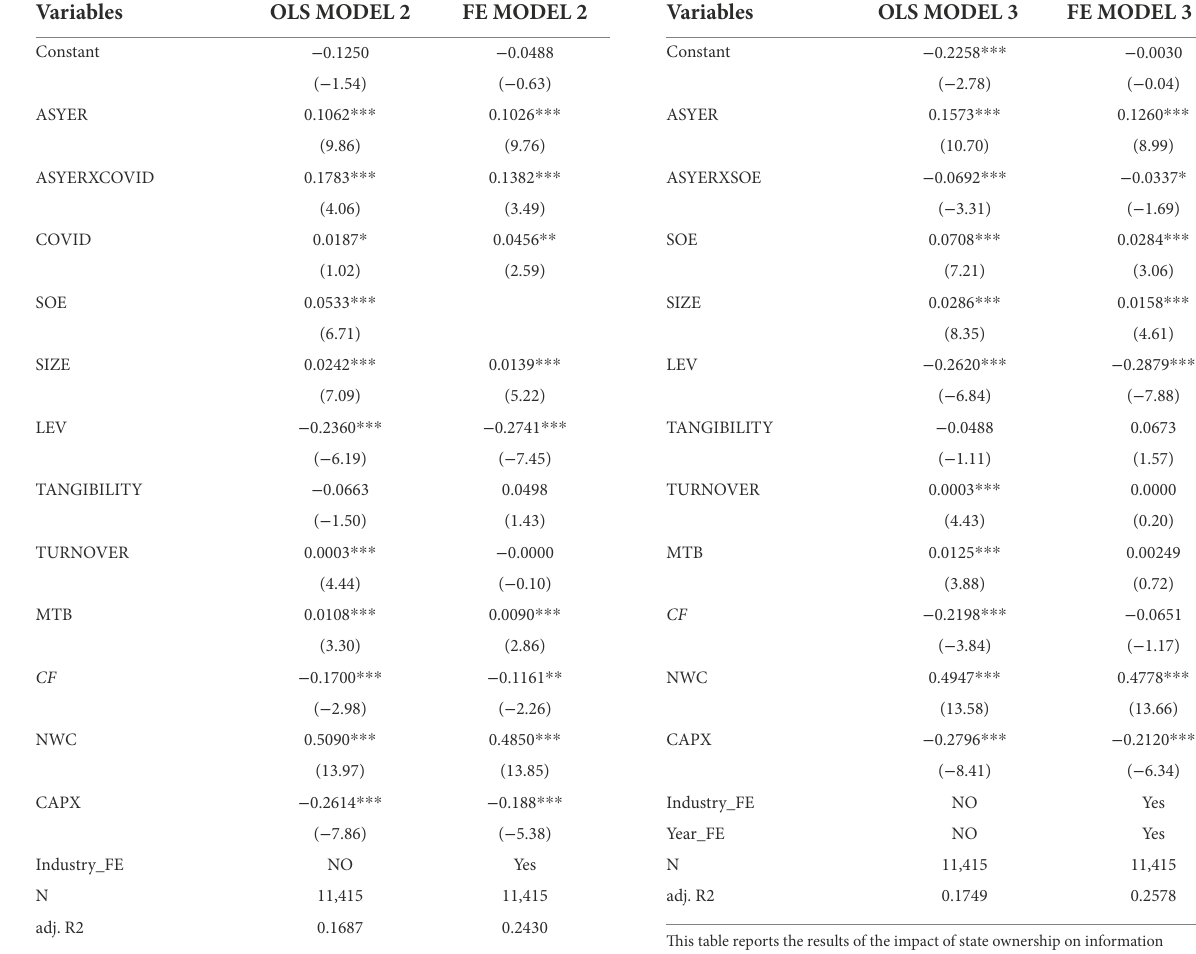
TABLE 5 Information asymmetry and corporate cash holdings — impact of COVID-19.